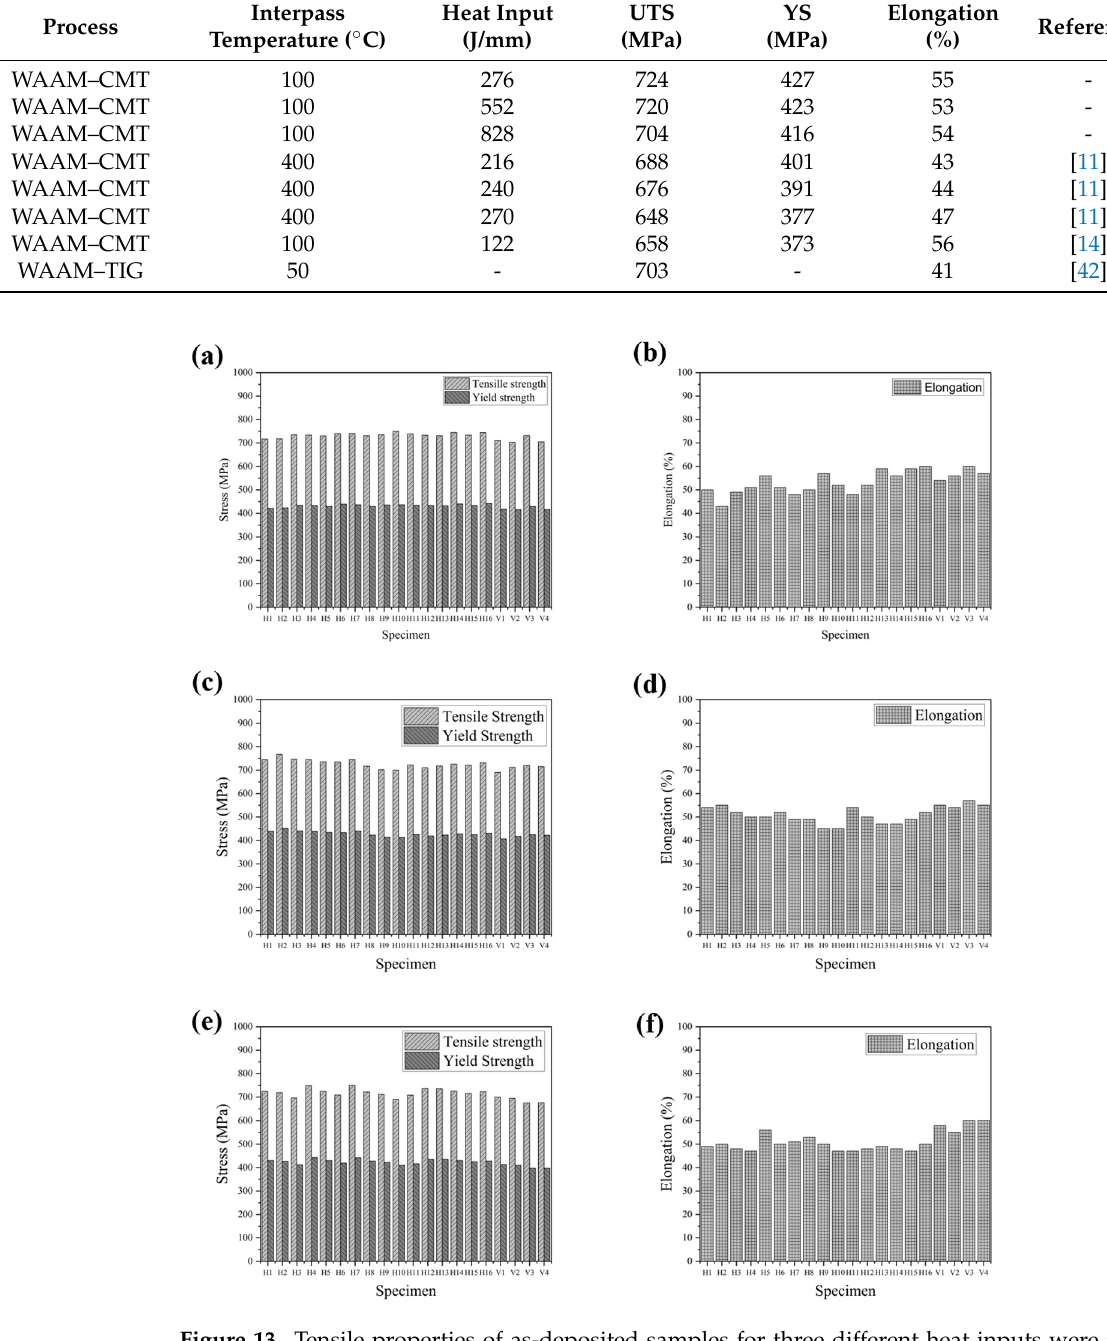
Figure 13. Tensile properties of as-deposited samples for three different heat inputs were taken from horizontal (x–y plane) and vertical (y–z plane) directions: ( a , b ) 276 J/mm, ( c , d ) 552 J/mm and ( e , f ) 828 J/mm.